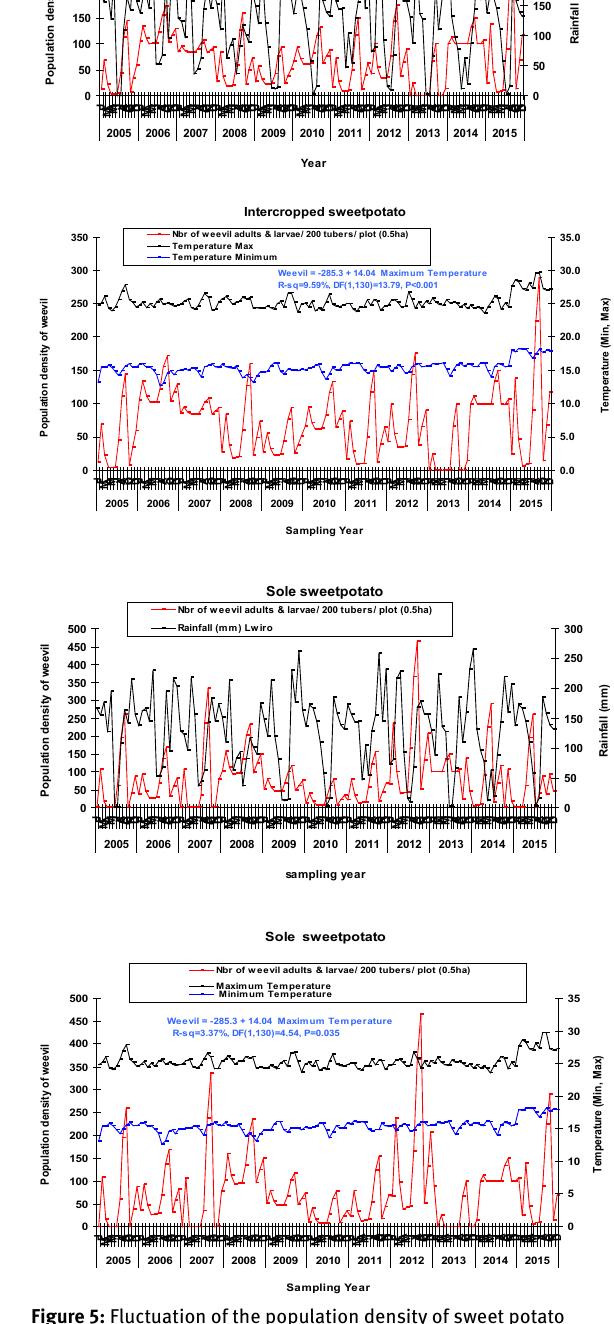
Figure 4: Fluctuation of the population density of sweet potato but- terfly pest in relationship with variability in climatic factors (rainfall, temperature) under intercropping and mono-cropping systems in Kivu, eastern DRCongo